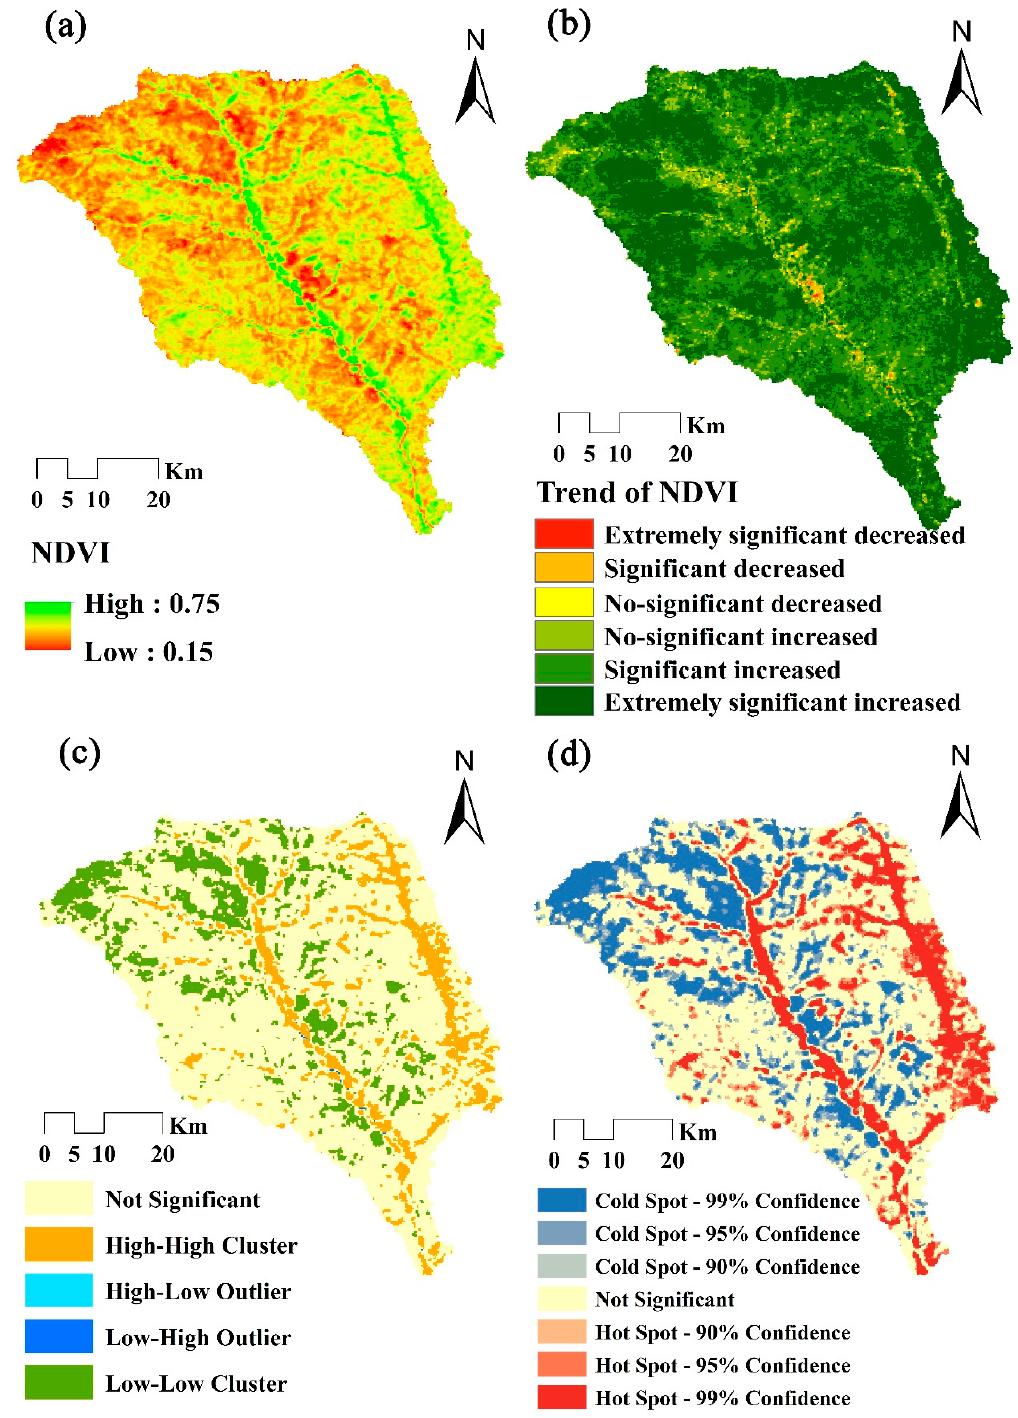
Figure 5. Change in NDVI in the Huangfuchuan Watershed from 2000 to 2020: ( a ) spatial distribution of multi-year average NDVI, ( b ) trend of NDVI, ( c ) spatial autocorrelation of NDVI; and ( d ) cold and hot spots analysis.